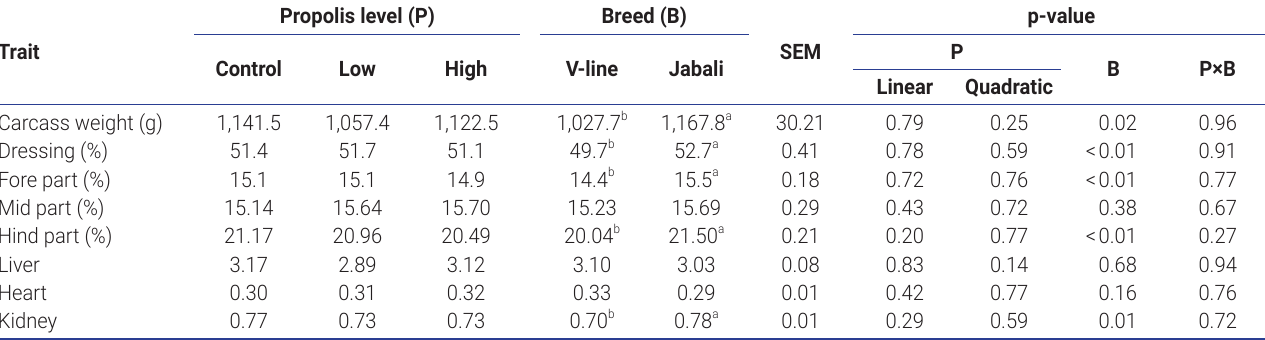
Table 4. Effect of propolis level and breed on carcass traits and relative weight of internal organs in rabbits